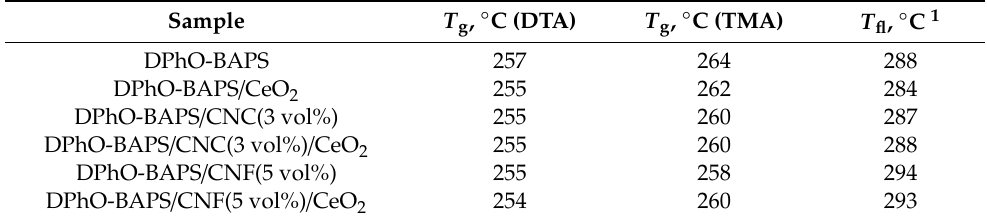
Thermomechanical characteristics of DPhO-BAPS (PI with a repeating unit based on 2,3,3 (cid:48) ,4 (cid:48) -diphenyl ether tetracarboxylic acid dianhydride (dianhydride DPhO) and 4,4 (cid:48)